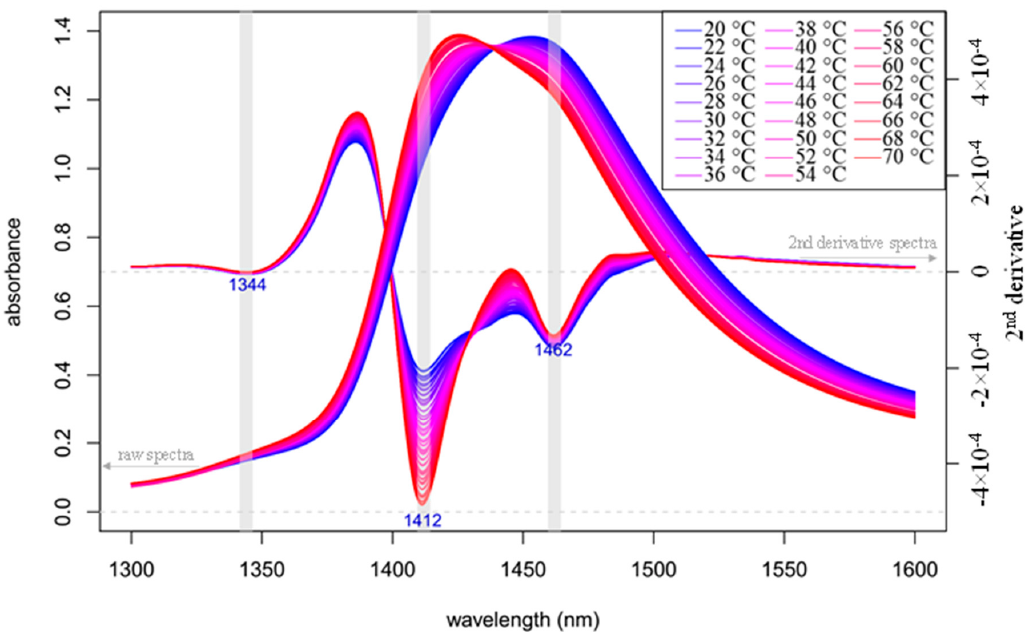
Figure 2. Raw and 2nd derivative (calculated with Savitzky–Golay filter using 2nd order polynomial and 21 points) absorbance (logT − 1 ) spectra in the spectral range of 1300–1600 nm (OH first overtone) of Milli-Q water in the temperature range of 20–70 °C ( n = 78).